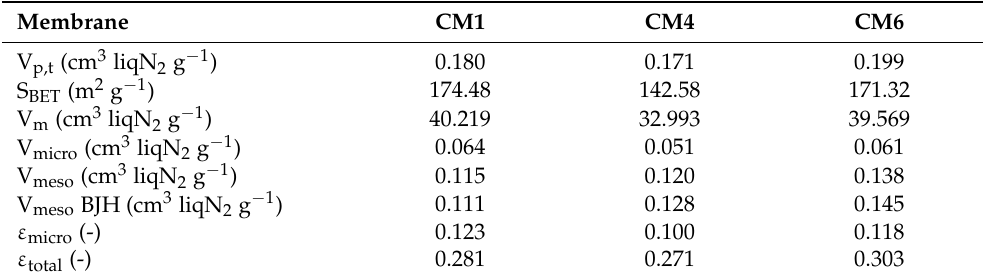
Table 6. Pore structure analysis results from this study. The volume of mesopores, V meso , presented in the CM1, CM2, and CM6 samples, was determined by subtraction of the total micropore volume from the total pore volume (i.e., V meso = V 0.97 − V micro ) and also by the BJH method (i.e., V meso BJH ). Membrane CM1 CM4 CM6 0.180 0.171